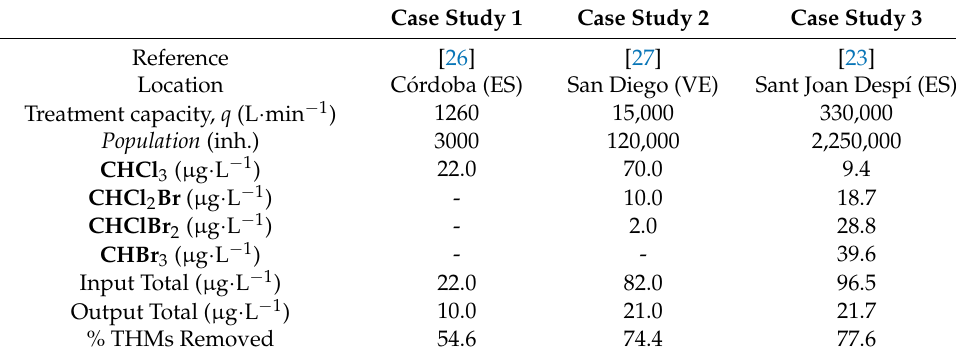
Table 3. General information of the case